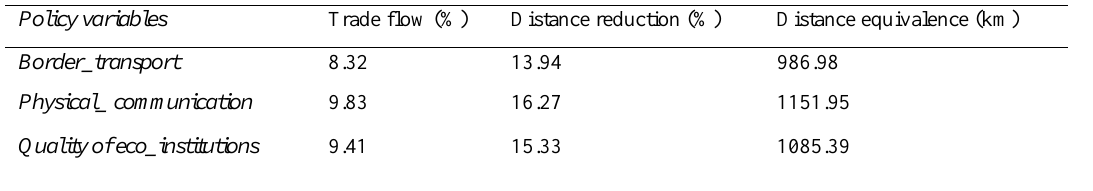
Table 5 : Simulation